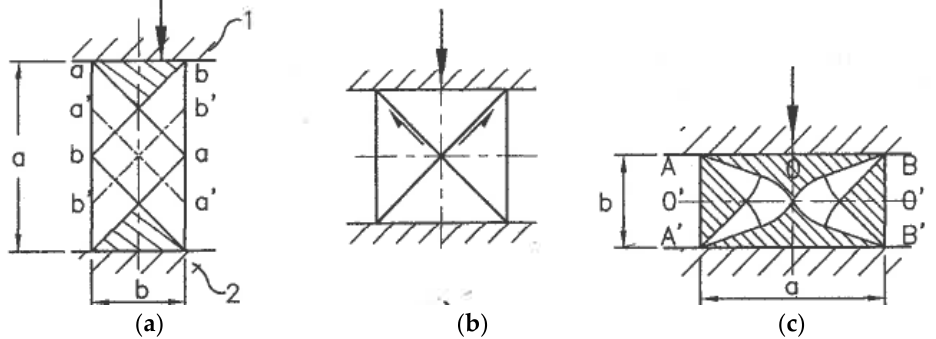
Figure 20. Plastic zones during two-directional plane forging: ( a ) Original position; ( b ) Intermediate position; ( c ) Final position.